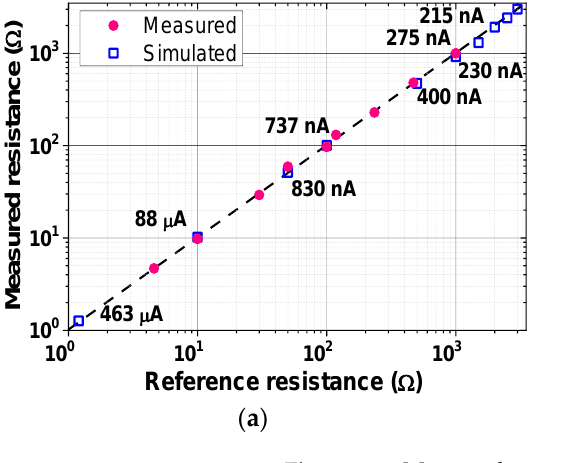
Figure 25. Measured range of the ETI system for ( a ) differential resistance and ( b ) differential capacitance. The values of the injected current are also shown.